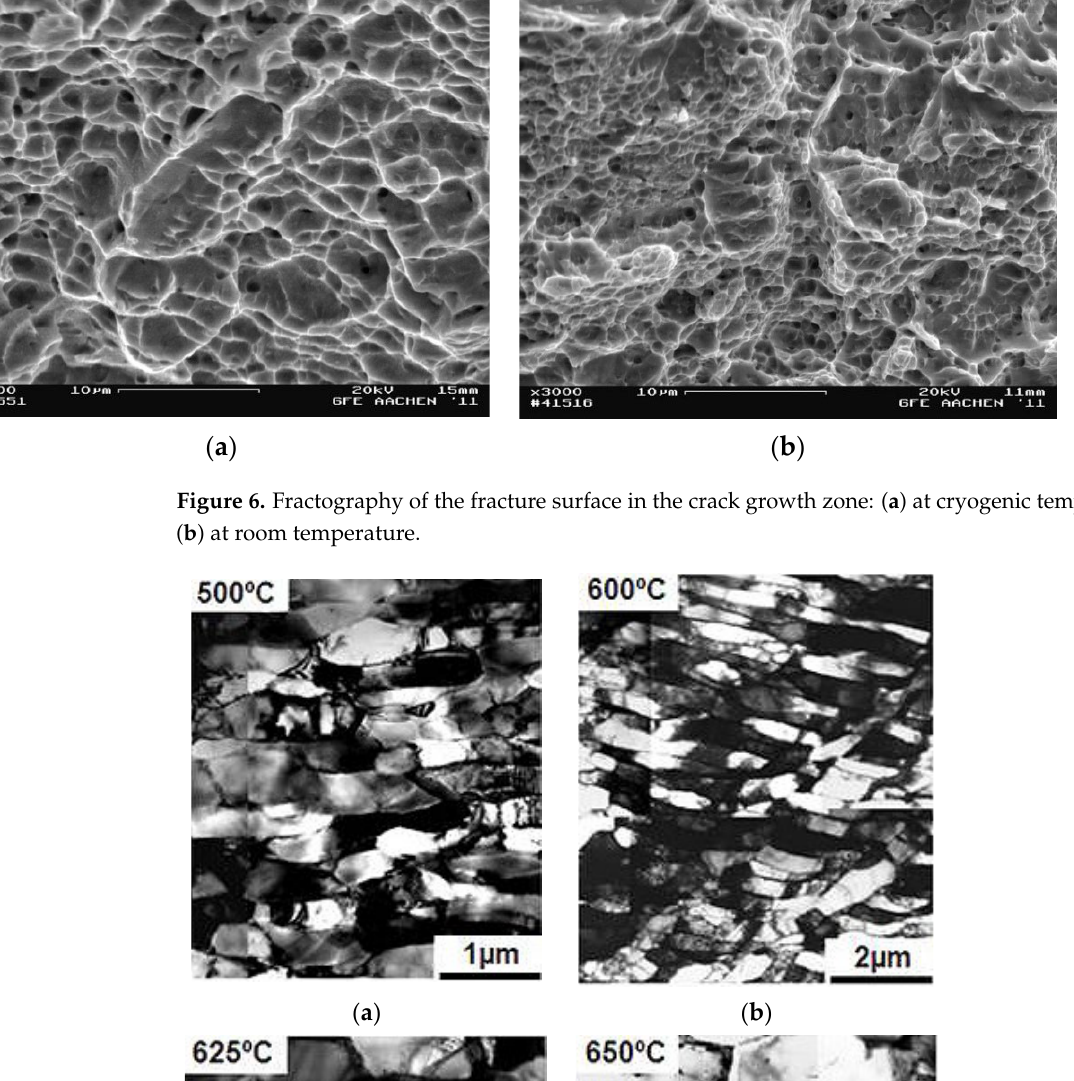
Figure 6. Fractography of the fracture surface in the crack growth zone: ( a ) at cryogenic tempera- ture; ( b ) at room temperature.